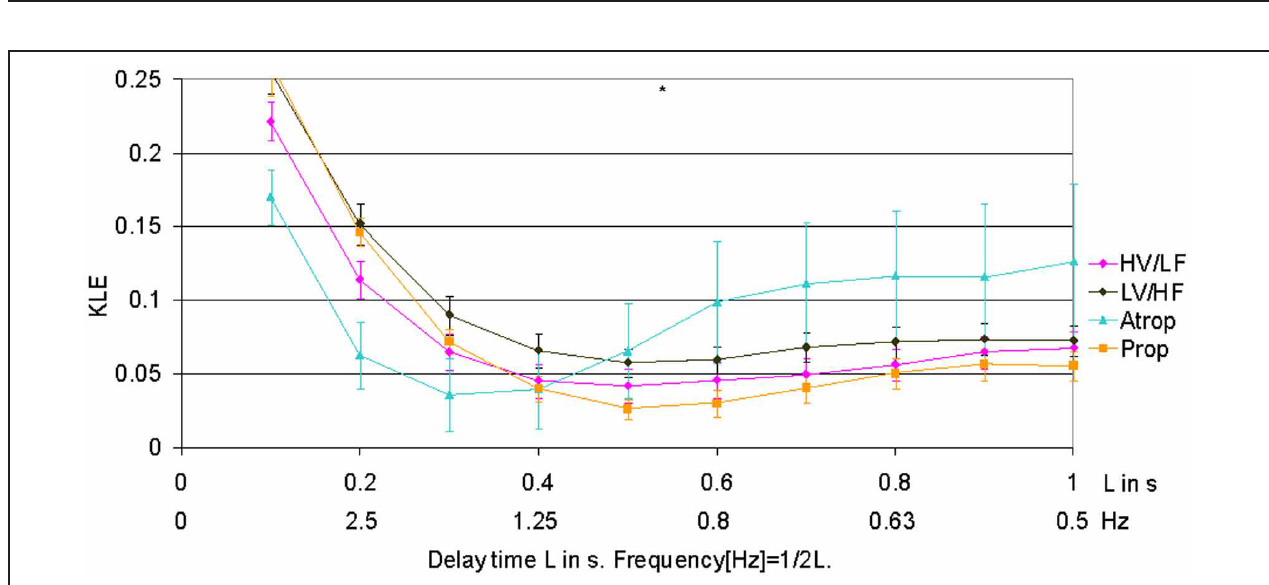
FIGURE 1 | KLE for varying delay time L (in seconds). Increasing complexity corresponds to decreasing KLE values. The whiskers indicate the standard error of the mean. Atropine administration results in profound reduction of complexity on most of the time scales, while propranolol causes